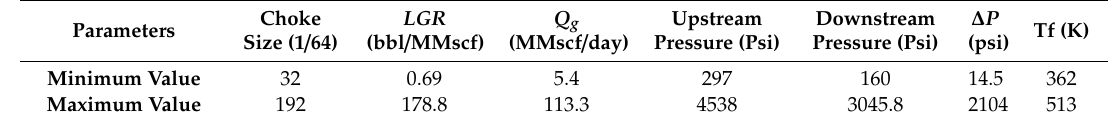
Table 1. The range of di ff erent production